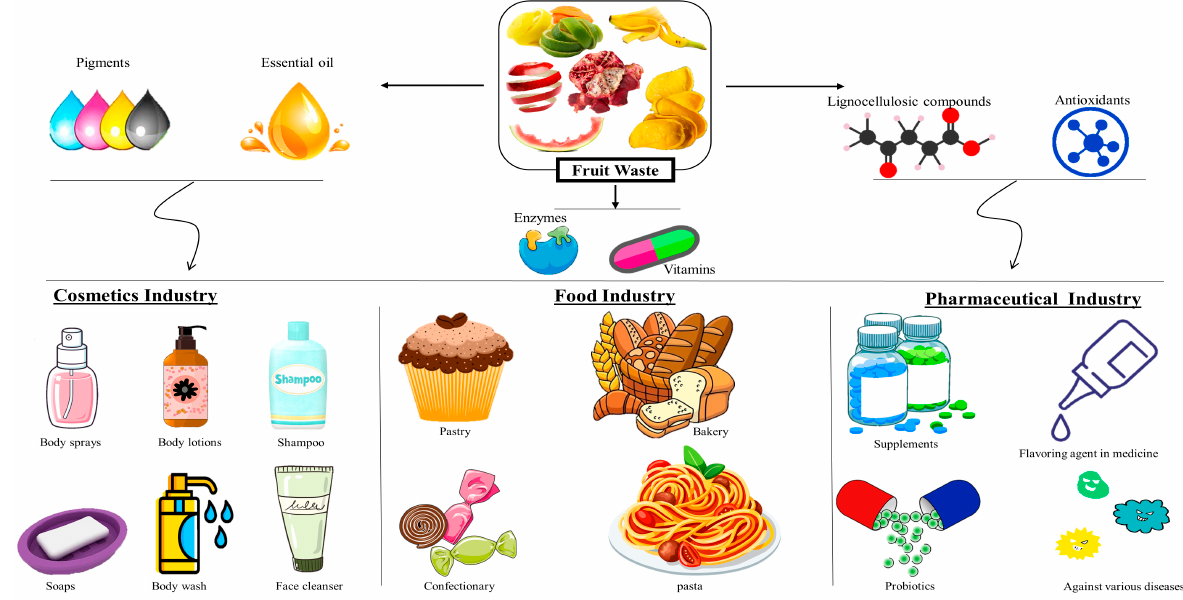
Figure 1. Graphical representation of fruit waste and its usage in different industrial sectors.